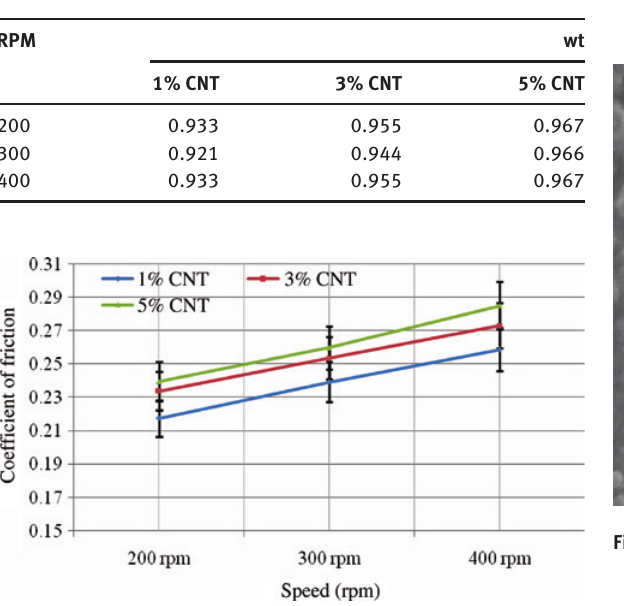
Table 3: Weight loss ratio with respect to speed for various wt% of CNTs.